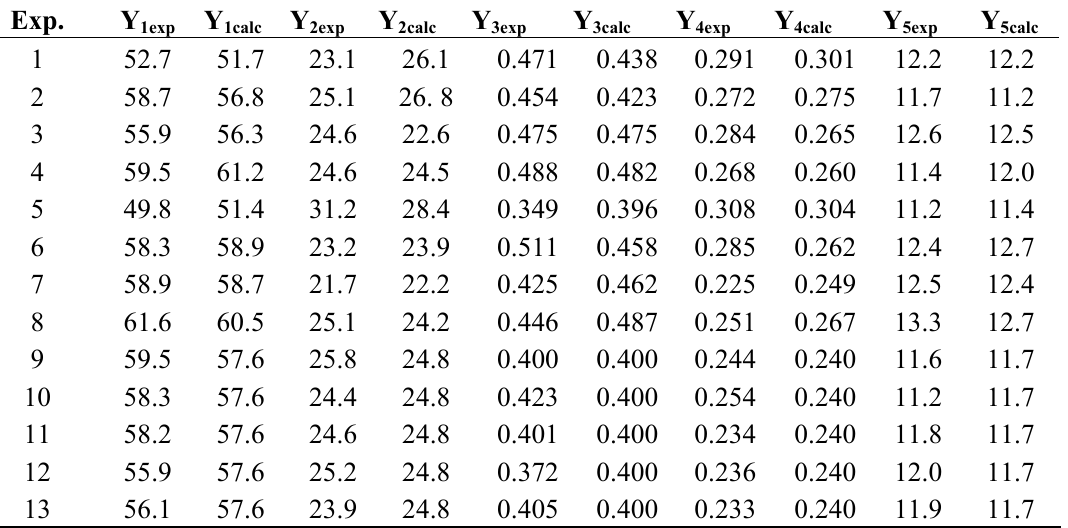
Table 3. Experimental and calculated values of the objective functions during desorption from Sepabeads SP207 resin. Exp.